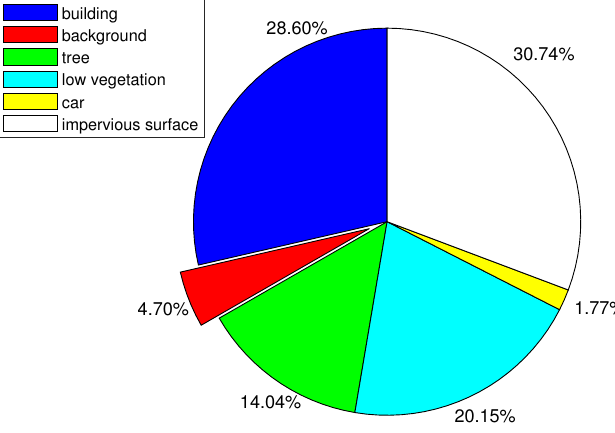
Figure 2. Category distribution of Potsdam training